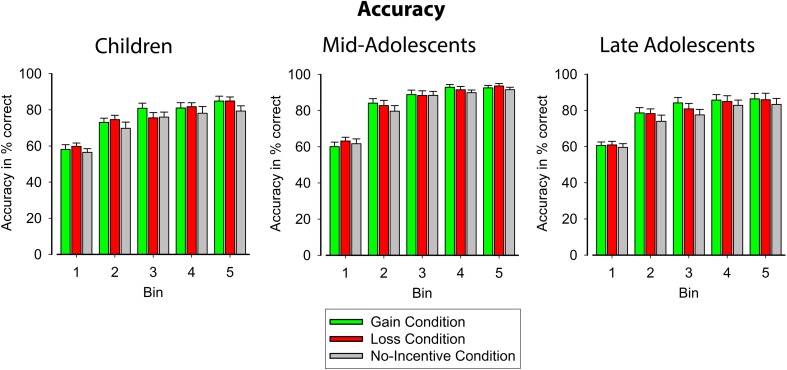
Learning-related changes in accuracy rates for the three incentive conditions, displayed separately for children (left), younger adolescents (middle), and older adolescents (right). The x-axis shows the course of learning averaged into 5 bins. Error bars indicate standard error.